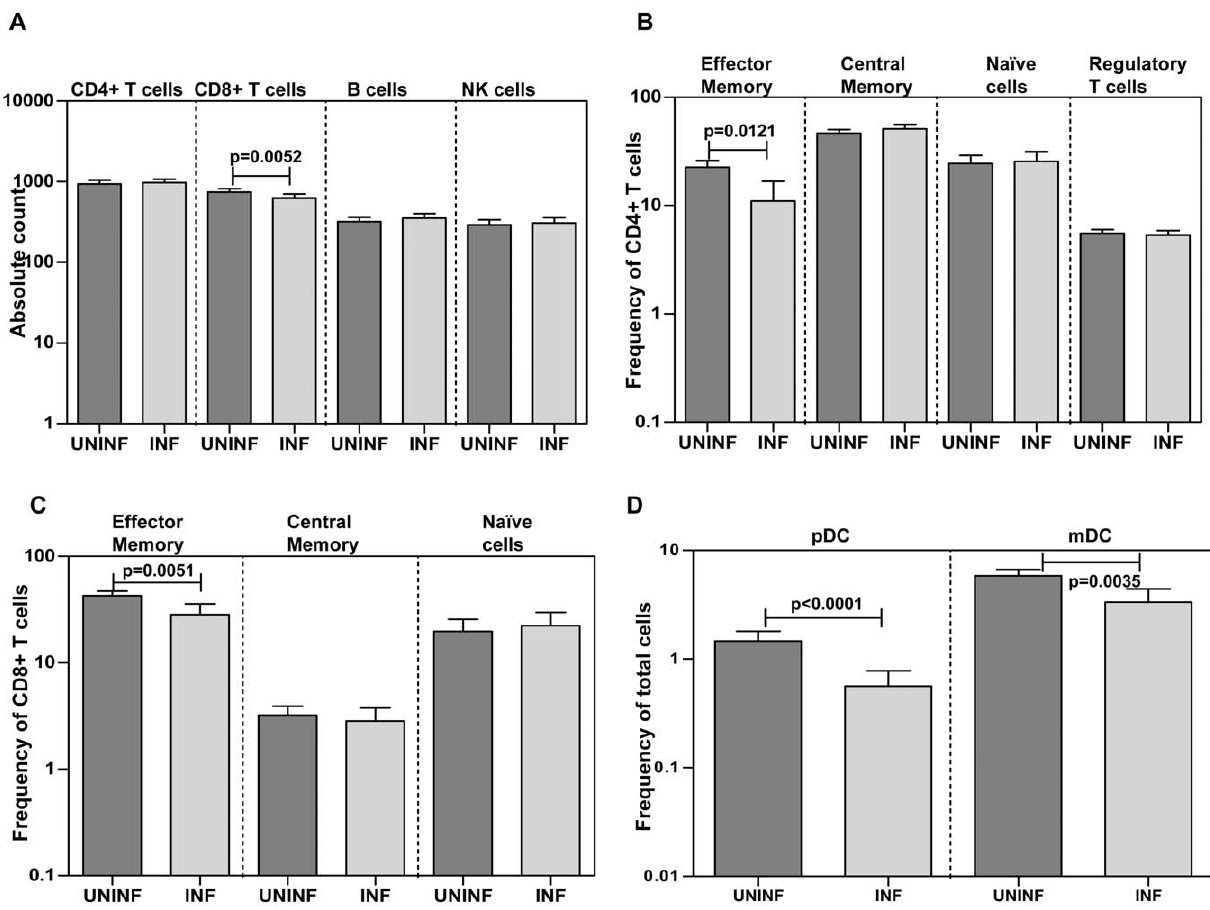
Figure 3. Hookworm infection is associated with decreased CD8 + T cells and dendritic cell (DC) subsets. A , Absolute counts of CD4 + and CD8 + T cells, B cells, and NK cells in INF (n=46) and UNINF (n=45) individuals were measured by flow cytometry. B , Percentages of effector memory (CD45RA 2 CCR7 2 ), central memory (CD45RA 2 CCR7 + ), and naı¨ve (CD45RA + CCR7 + ) CD4 + T cells as well as natural regulatory T cells (CD4 + CD25 + Foxp3 + CD127 dim ) in INF (n=31) and UNINF (n=40) were measured by flow cytometry. C , Percentages of effector memory (CD45RA 2 CCR7 2 ), central memory (CD45RA 2 CCR7 + ), and naı¨ve (CD45RA + CCR7 + ) CD8 + T cells in INF (n=31) and UNINF (n=40) were measured by flow cytometry. (D) Percentages of plasmacytoid (pDC; HLA-DR + CD123 + ) and myeloid DC (mDC; HLA-DR + CD11c + ) in INF (n=46) and UNINF (n=45) were measured by flow cytometry. P values were calculated using the Mann-Whitney test.